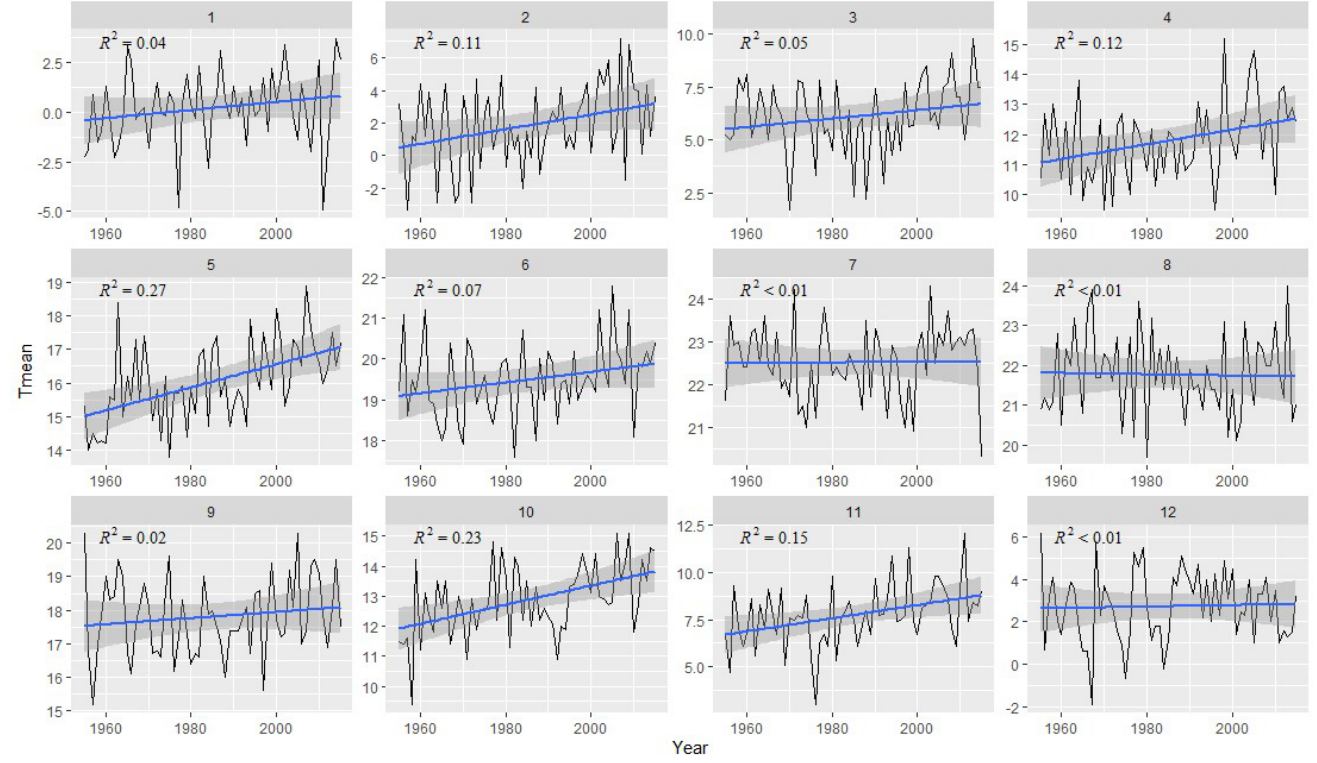
Figure A2. Climate trends of monthly temperature during 1955–2014.